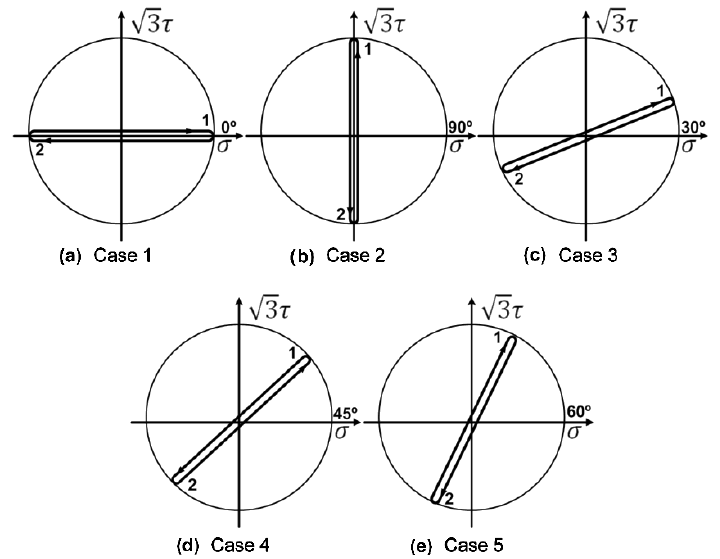
Figure 2. Proportional loadings performed in the fatigue life experimental program, ( a ) Case 1 and ( b ) Case 2 are the uniaxial normal and shear loading cases, ( c ) Case 3 is the proportional loading with a shear to normal stress ratio equal to tan(30°), ( d ) Case 4 is the proportional loading with a shear to normal stress ratio equal to tan(45°), and ( e ) Case 5 is the proportional loading with a shear to normal stress ratio equal to tan(60°).